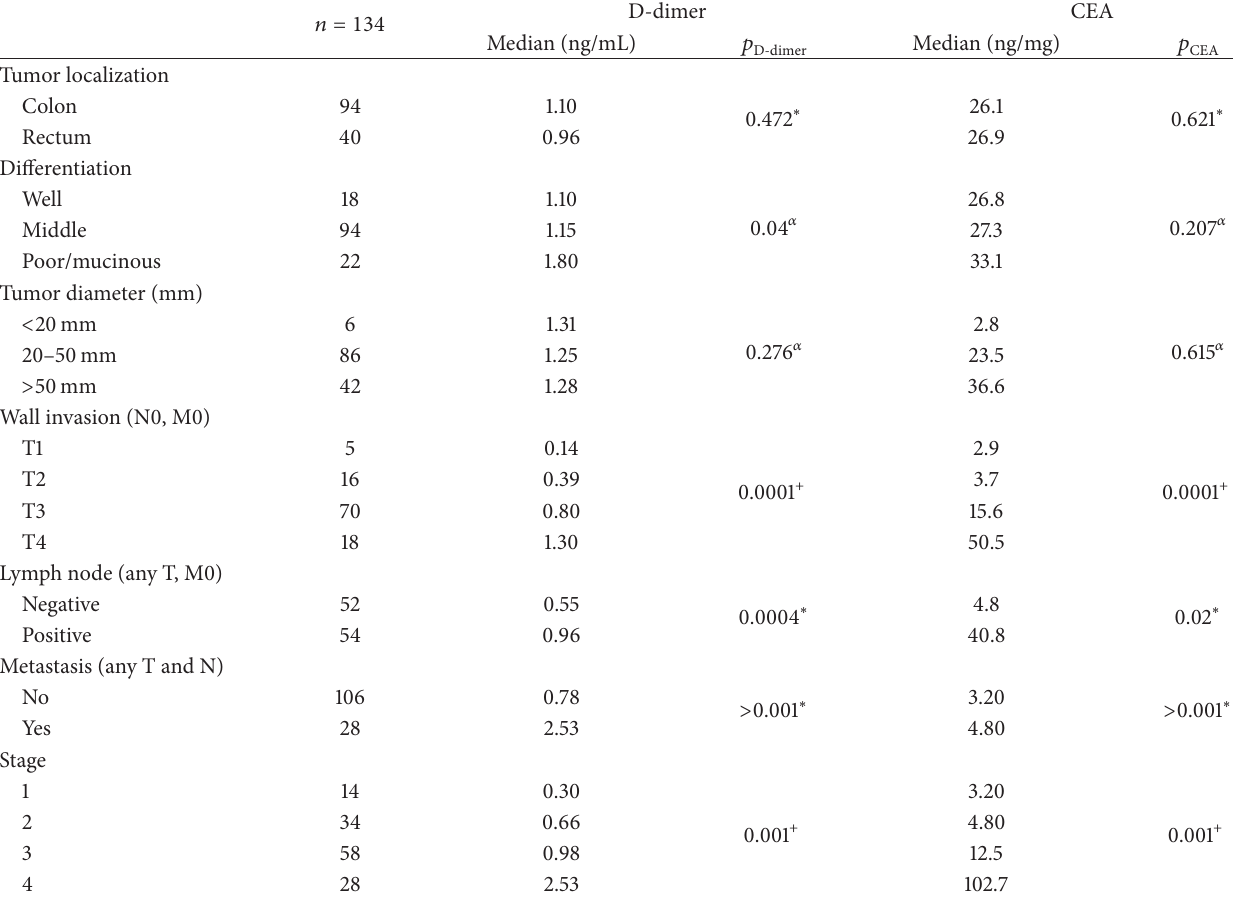
Table 1: Relationship between the investigated parameters and the plasma D-dimer and serum CEA levels.